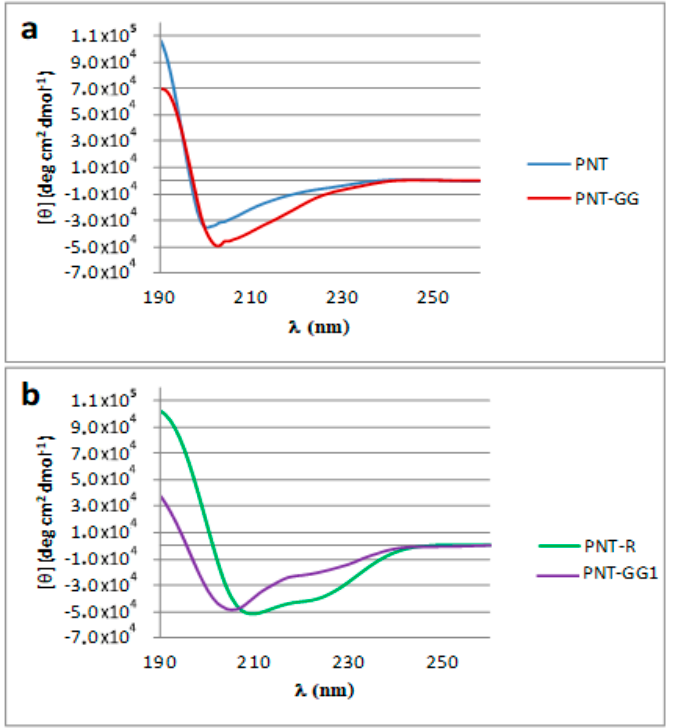
Figure 2. CD spectra for PNT (blue line), PNT-GG (red line) ( a ) and PNT-R (green line), PNT-GG 1 (purple line) ( b ) in 40% HFIP/PBS solution.